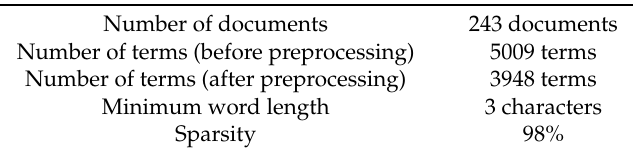
Table 1. Preprocessing of text